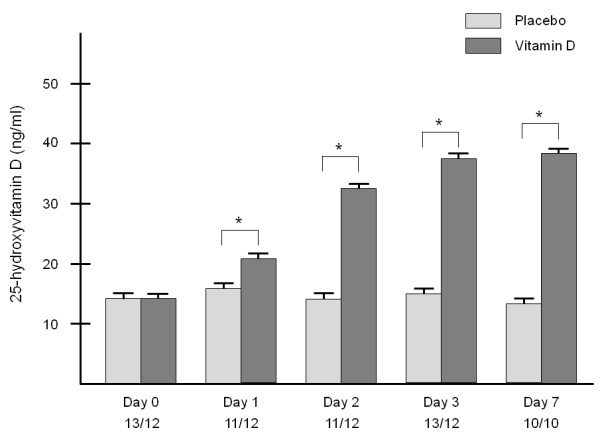
Mean 25-hydroxyvitamin D levels (±SEM) after a single enteral dose of 540,000 IU vitamin D3 or placebo in vitamin D deficient patients at a medical ICU. The numbers given below the study days refer to the number of patients per group.